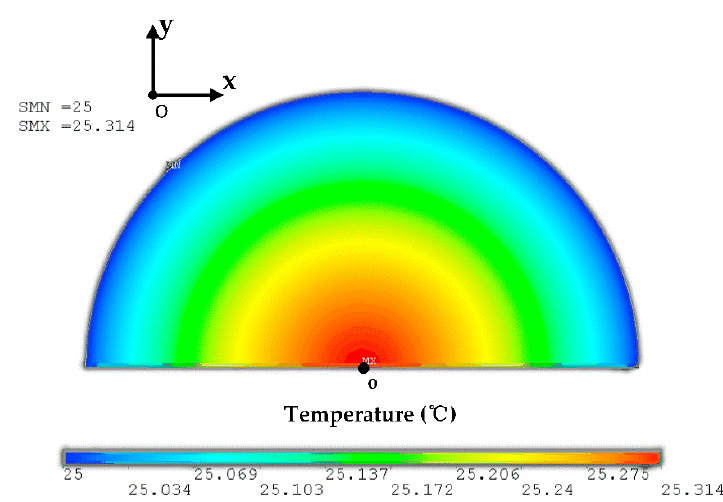
Figure 10. The average temperature profile of the laser rod in the annular liquid-cooling scheme.